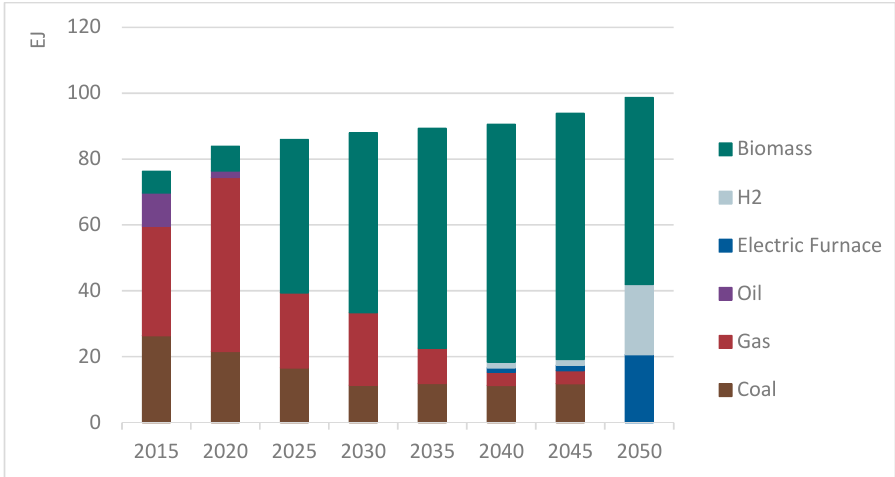
Figure 7. Development of global high-temperature heat production.